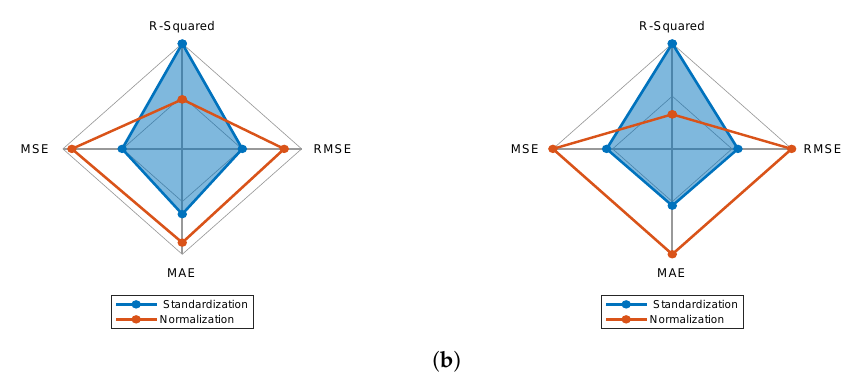
Figure 5. Our proposed model performance with different features scaling techniques for confirmed cases in Saudi Arabia. ( a ) Our proposed model performance during the first wave starting. ( b ) Our proposed model performance during the first wave